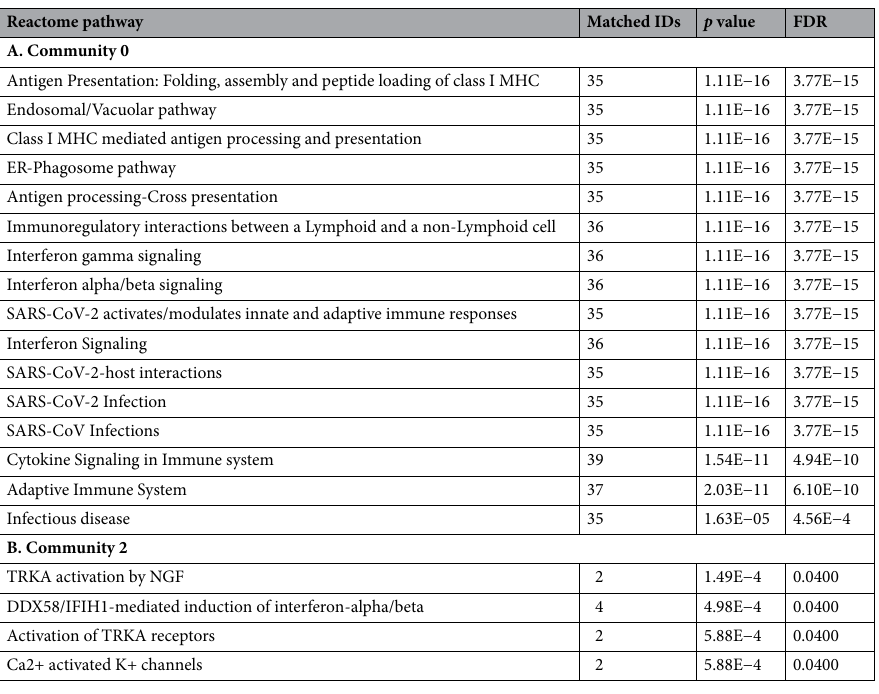
Table 4. Statistically significant (FDR < 0.05) Reactome pathways results of top quartile highest genes for Communities 0 and 2.